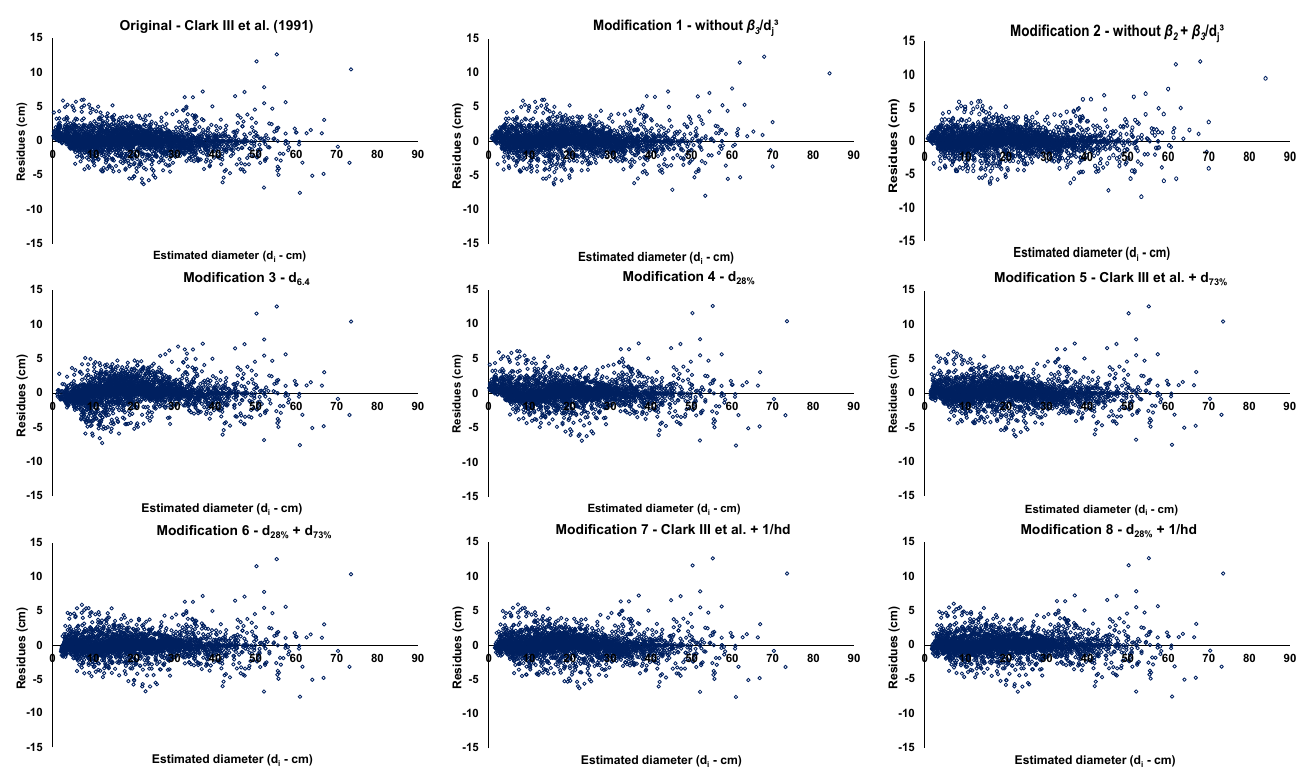
Figure 5. Residues of the estimates of relative diameters using the equations of Clark III et al. and the proposed modifications to the Tectona grandis L.f. data, central − west region, Brazil [30]. Modification 6, which replaces d 5.3 j with d 0.8 h and added β 6 × d 0.73 h , achieved a slight improvement in the adjustment statistics. Upon segmenting the Clark III et al. model [30]